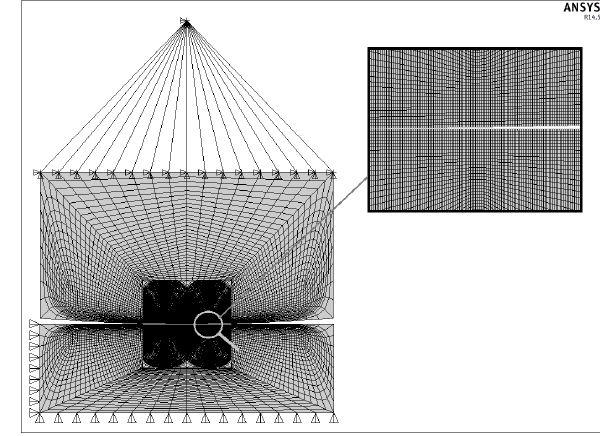
Figure 2: Mesh in the 2D models.